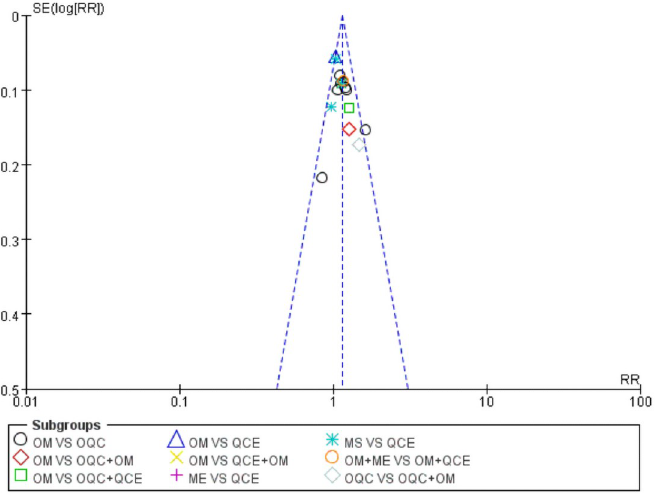
Fig 6. Funnel plot of clinical response. OM: Oral mesalazine; OQC: Oral Qingre-Chushi therapies; QCE: Qingre- Chushi therapies enema; ME: Mesalazine enema.